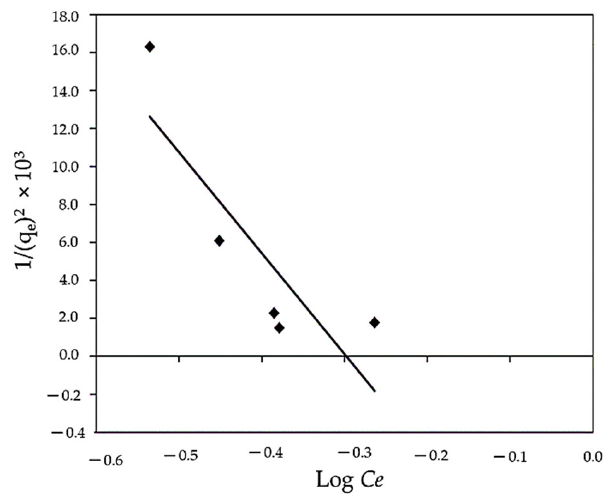
Figure 13. Linear Harkins–Jura isotherm for MBD sorption.